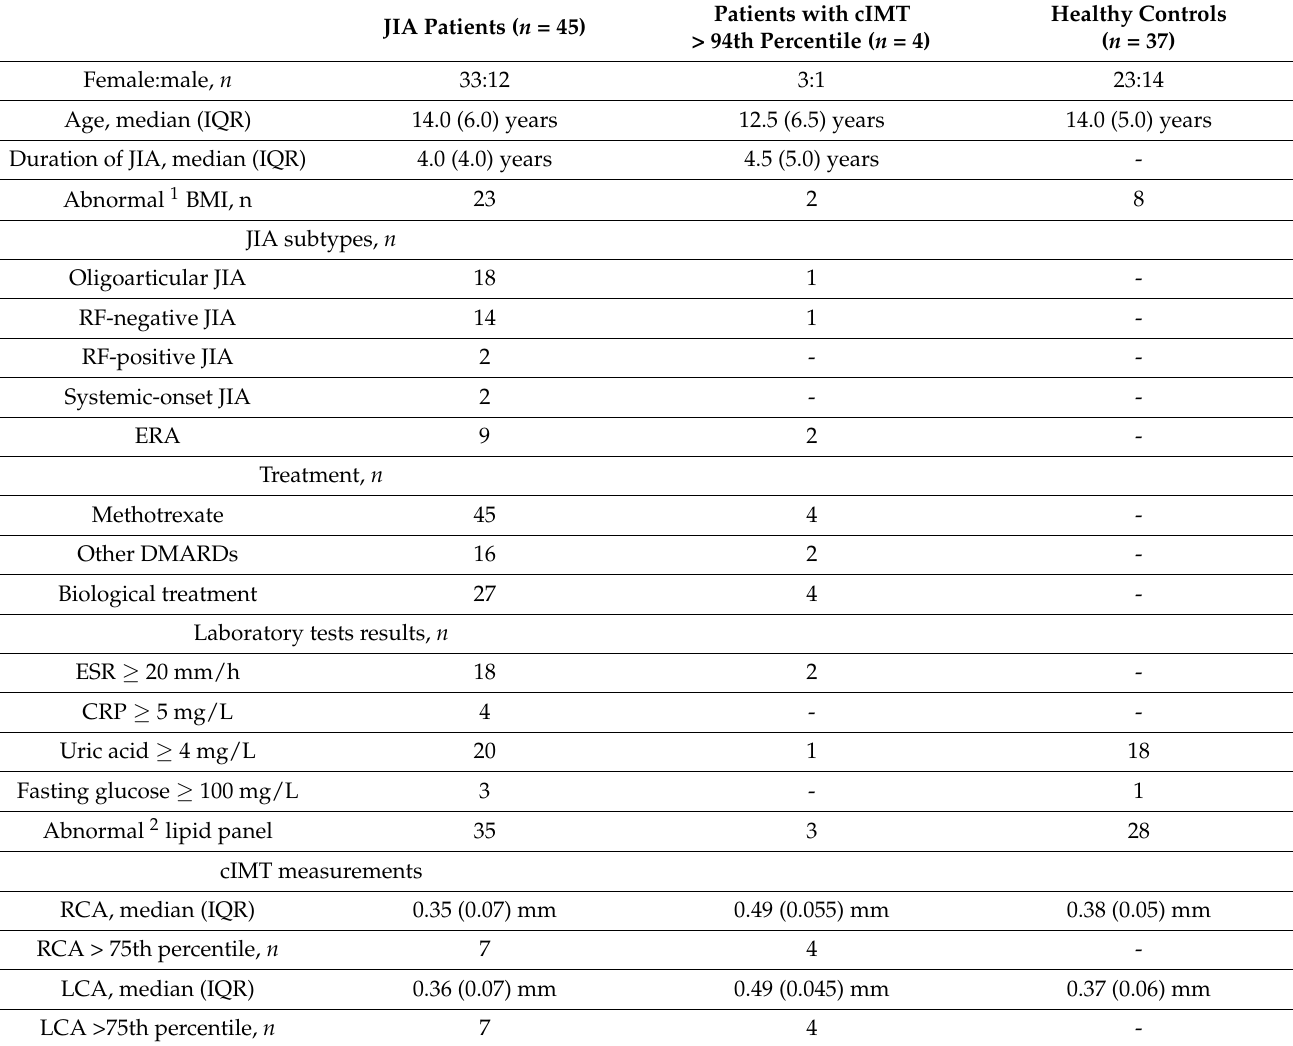
Table 1. General characteristics of the study